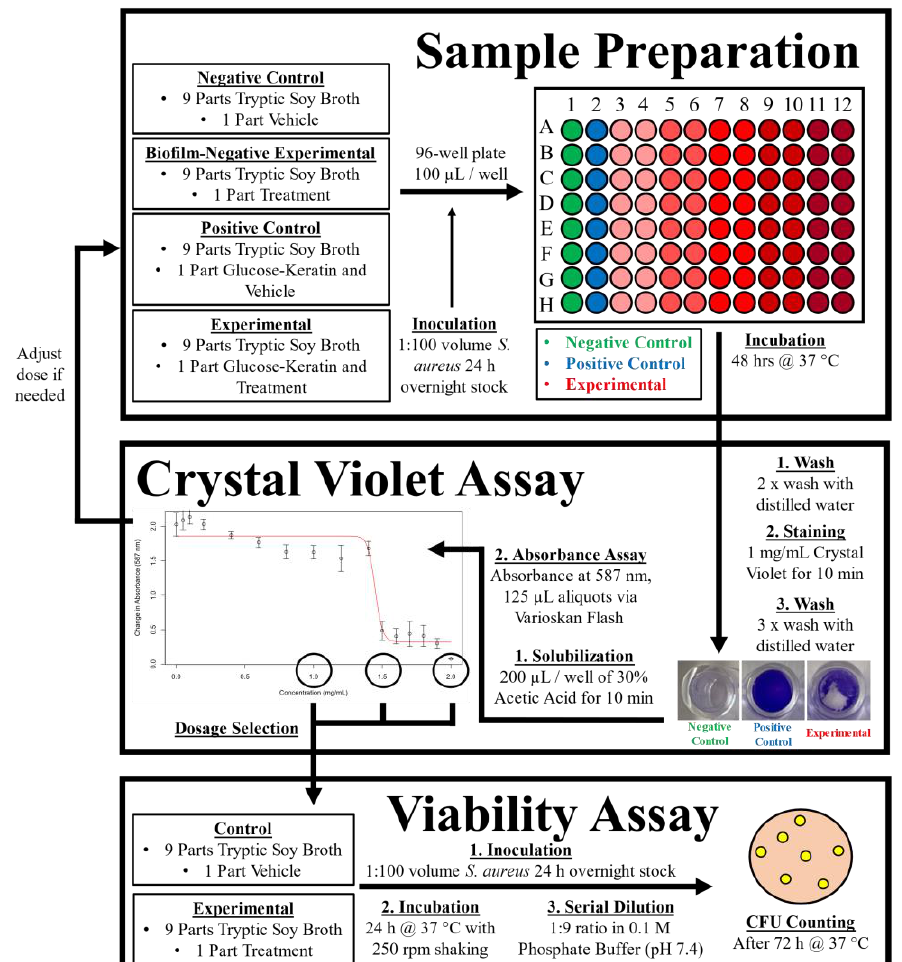
Figure 4. General Workflow Diagram.